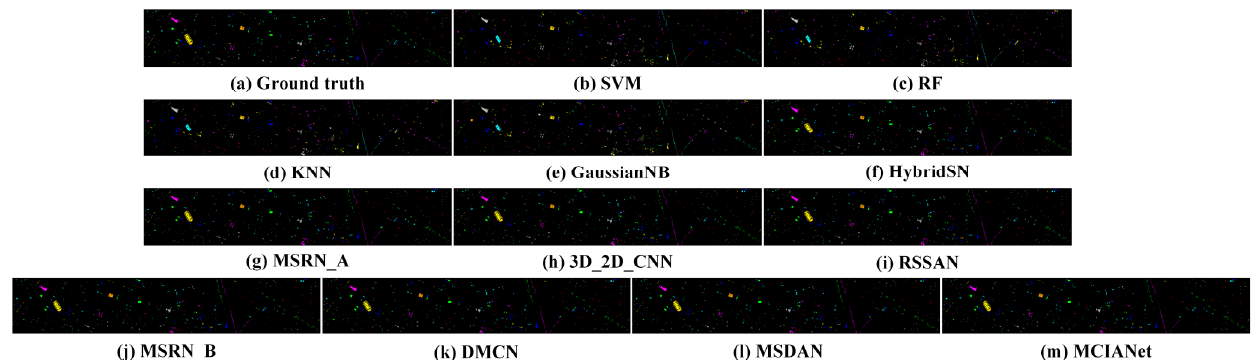
Figure 6. The classification visual maps on Houston 2013 dataset.